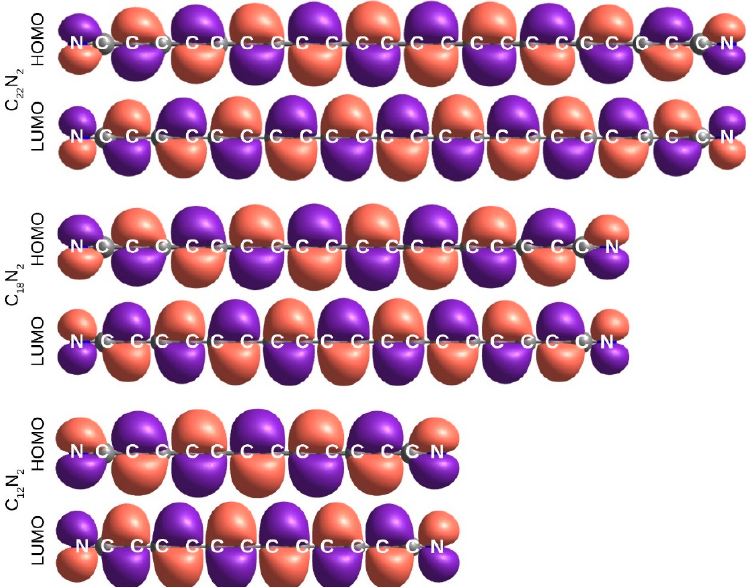
Figure 7. HOMO and LUMO molecular orbitals of select C 2 n +2 N 2 molecules (B972/aug-cc-pVTZ). The unabridged figure is available in Supplementary Materials (Figure S2).